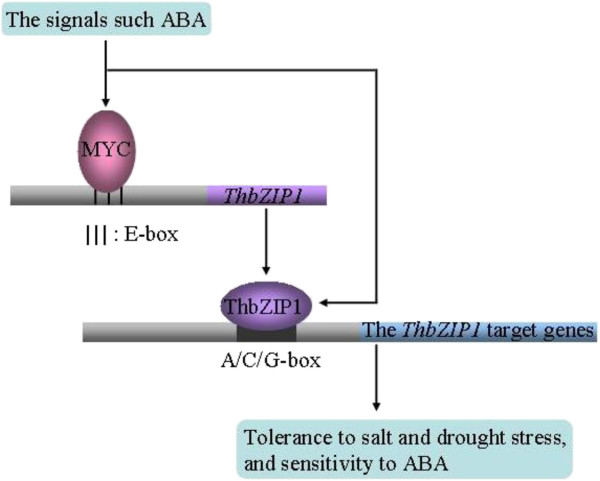
Model of the regulatory network of ThbZIP1 involved in abiotic stress responses. Stress signals such as ABA are produced in plants when exposed to abiotic stressors, and the expression of MYC is induced by stress signals; then the MYC proteins bind to the E-box motif in the promoter of ThbZIP1 to activate the expression of ThbZIP1. The ThbZIP1 in turn binds to the A-, C- or G-box in the promoter of the genes to alter their expression, resulting that abiotic stress tolerances are improved in plants.